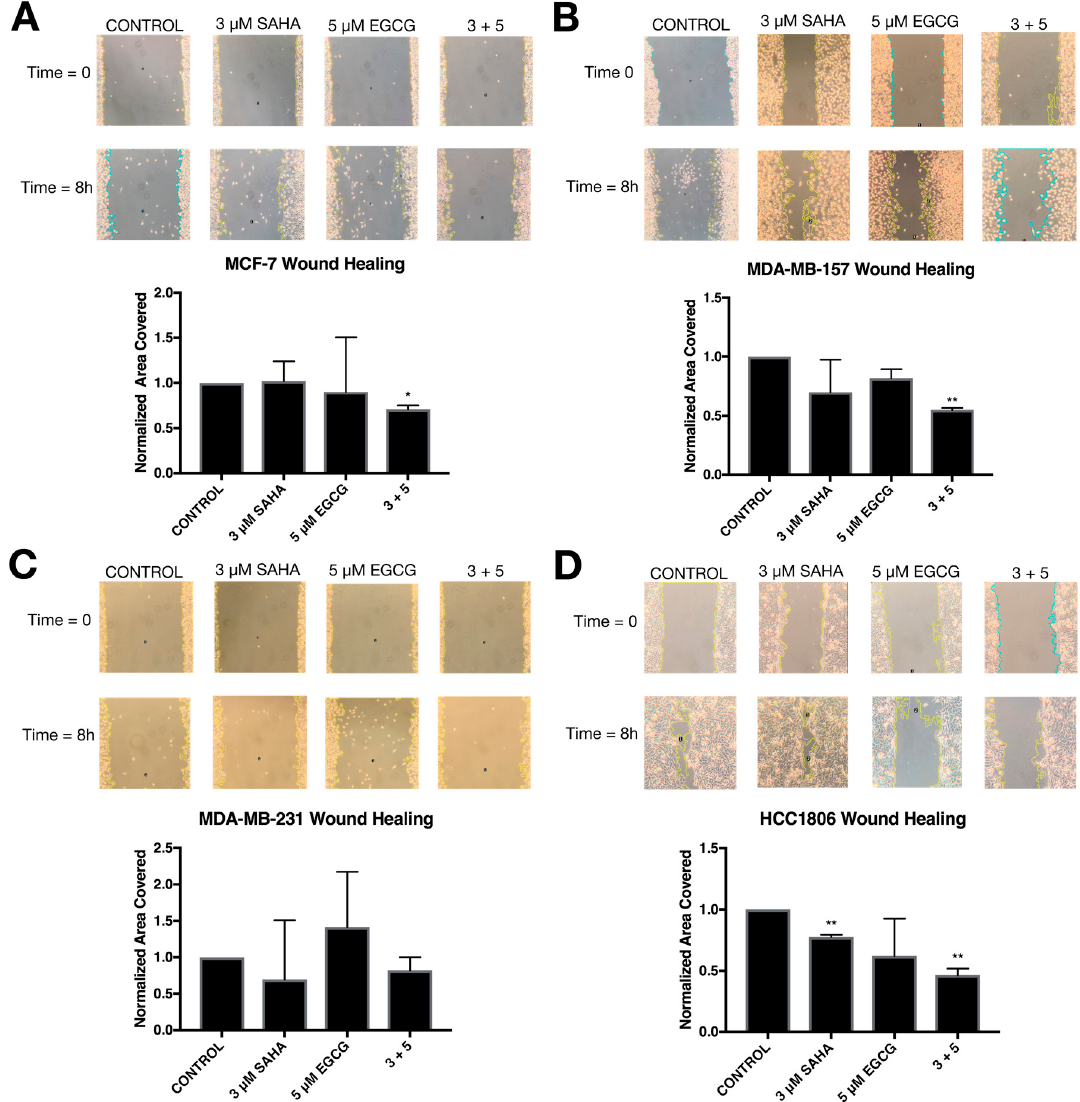
Figure 12. SAHA and EGCG are capable of inhibiting migration in MCF-7, MDA-MB-231, and HCC1806 breast cancer cells. ( A ) MCF-7 cells were treated with the indicated compounds for 72 h and then scratched using a 1000 μ L pipette tip. The culture media was replaced, and the cells were given 8 h to migrate. ( B–D ) The same procedure was completed with the MDA-MB-157, MDA-MB-231, and HCC1806 cells ( n = 3). Error bars represent standard error of the mean (SEM); * p < 0.05, ** p < 0.01. All photos were taken at 100× magnification.